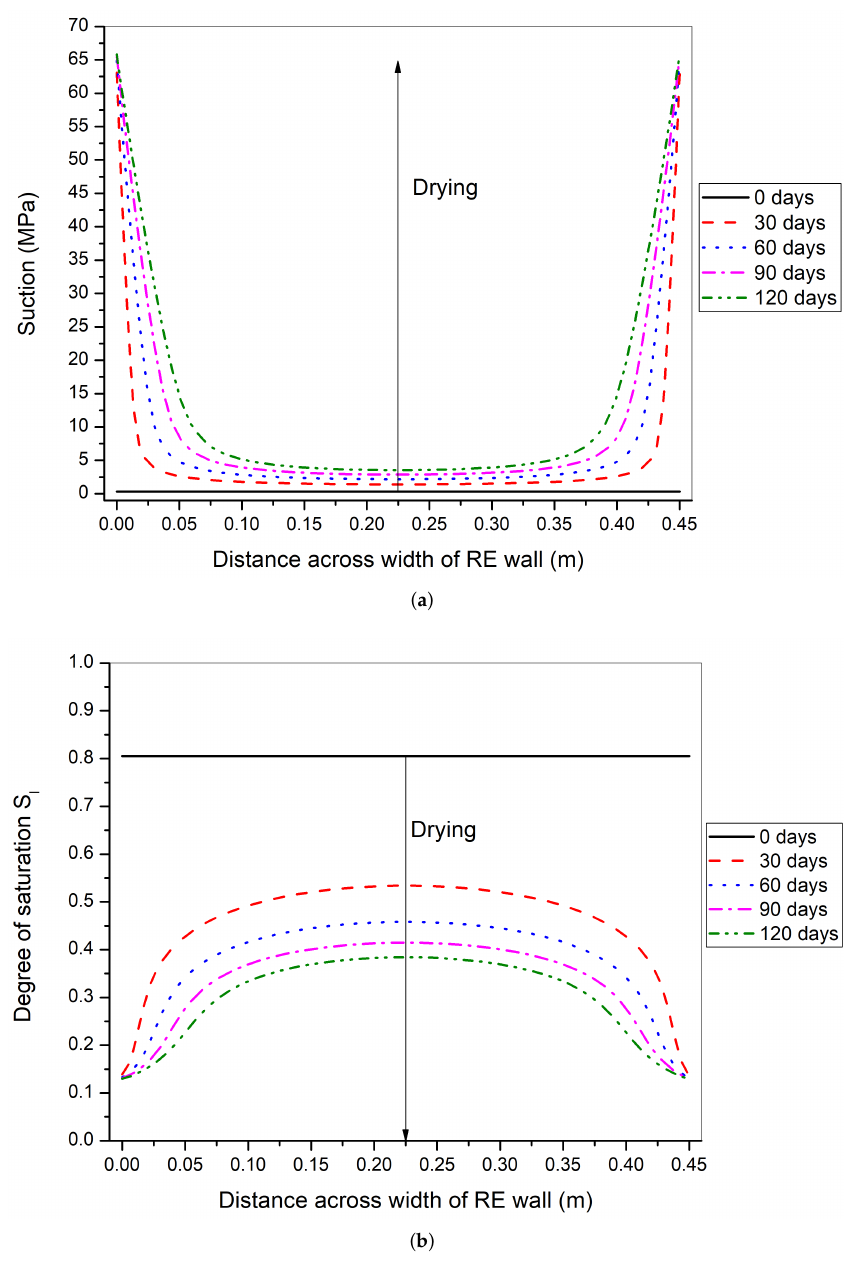
Figure 13. Suction ( a ) and degree of saturation ( b ) variation across the width of rammed earth wall at 0, 30, 60, 90, and 120 days of drying period in summer-like environmental